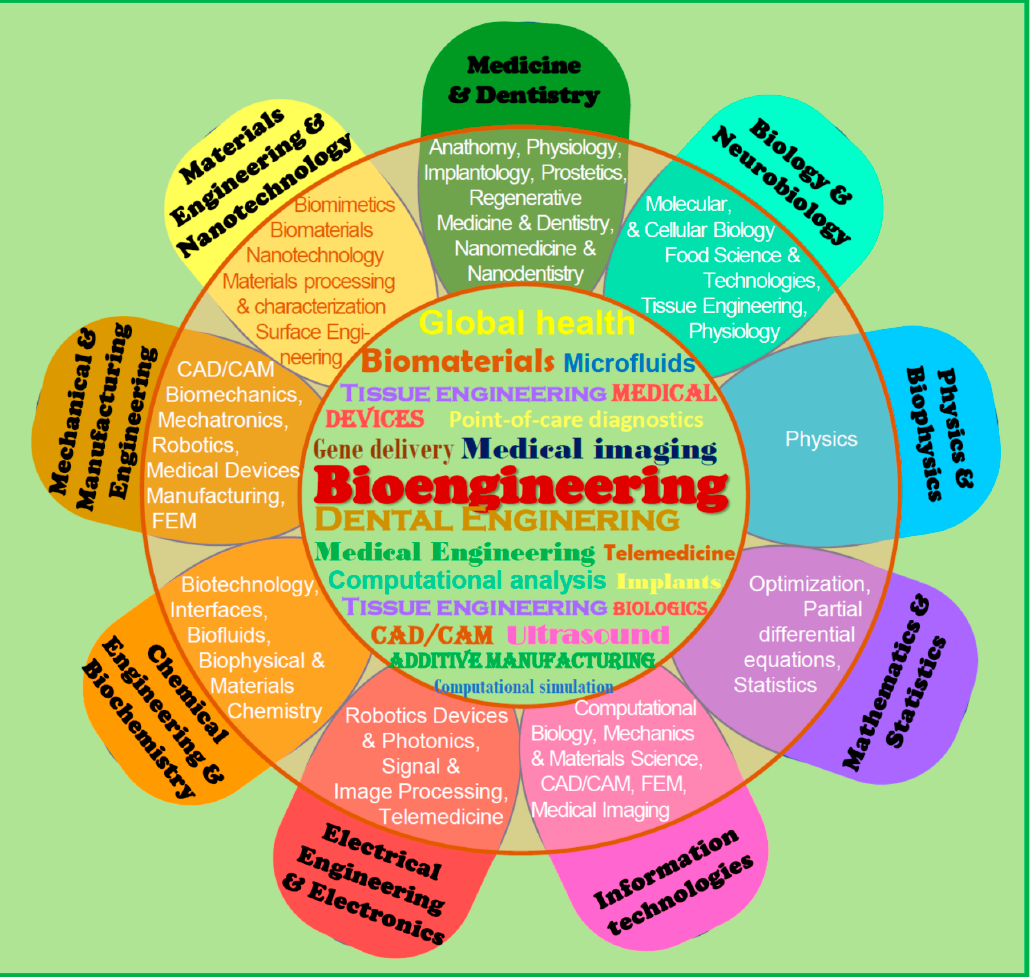
Figure 13. The flower of bioengineering showing a scheme of the scope of its interests, where each petal illustrates the interdisciplinary contribution of each discipline; the central circle corresponds to selected bioengineering problems; the middle circle determines the contribution of the detailed issues of each component disciplines.